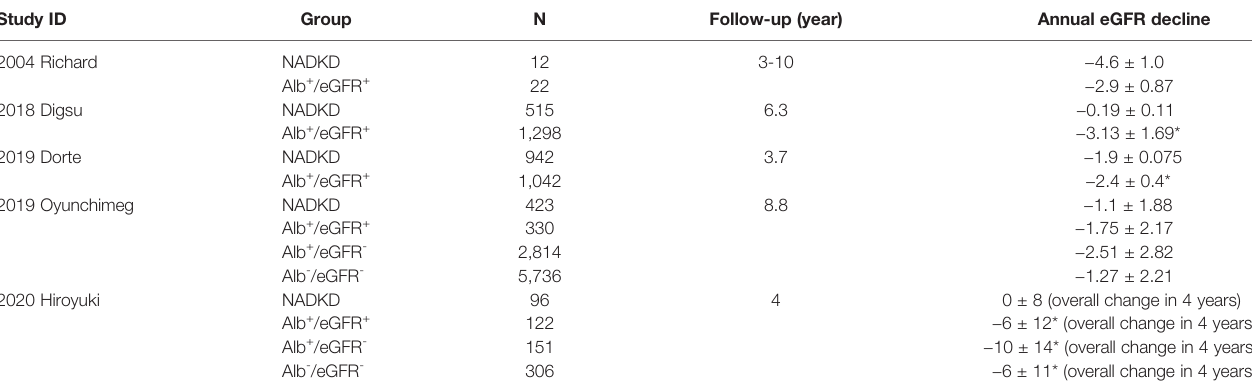
N indicates number; ID, identi fi er; eGFR, estimated glomerular fi ltration rate; NADKD, normoalbumunuria diabetic kidney disease; Alb+/eGFR+, albuminuria diabetic kidney disease with renalinsuf fi ciency;Alb+/eGFR-,albuminuriadiabetickidneydiseasewithoutrenalinsuf fi ciency;Alb-/eGFR-,nonalbuminuriadiabetickidneydiseasewithoutrenalinsuf fi ciency;*,compared with NADKD, p <